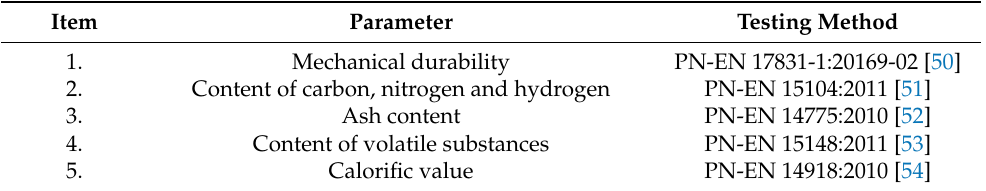
Table 1. Parameters analysed with research